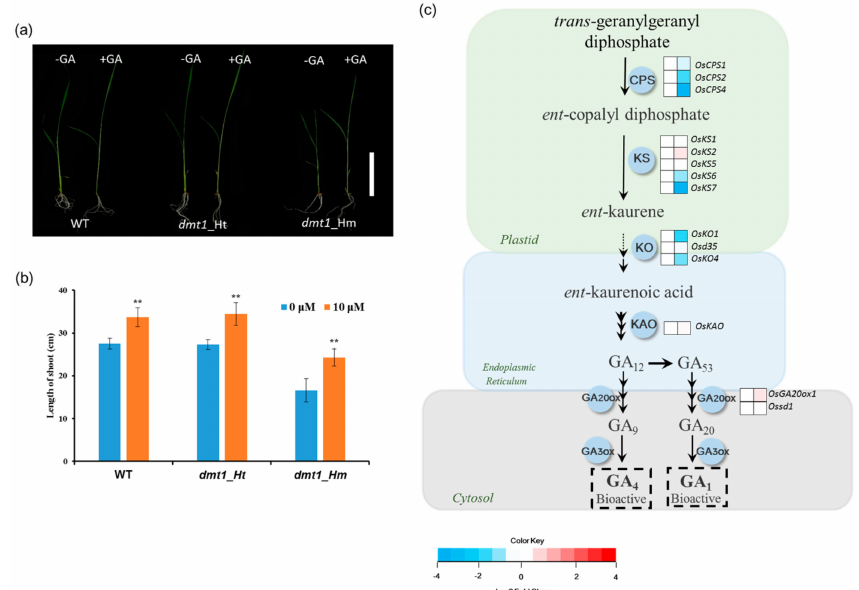
Figure 3. OsDMT1 involved in GA metabolism ( a ) GA response in the WT (left), heterozygous mutant (middle), and homozygous mutant (right). The 10-day-old WT, dmt1 homozygous, and heterozygous seedlings were sprayed with 0 µ M or 10 µ M gibberellin three times every 2 days, and the lengths of the shoots were measured on the 7 th day after the first treatment. Scale bar: 10 cm. ( b ) Quantitative measurements of the lengths of the shoot after GA treatment on the 7 th day in the WT, dmt1 heterozygous mutant and homozygous mutant. Values represented by means ± SE. ∗∗ p < 0.01, Student’s t -test; ( c ) Gene expression in the GA biosynthesis pathway between the dmt1 mutant and the WT. In the heatmap for each gene, two cells represent the WT and dmt1 mutant (left to right). Gene expression levels in the dmt1 mutant are indicated in the heatmaps by the log2 fold change relative to that of the WT. The dashed arrow represents several enzymatic reactions. CPS: ent-copalyl diphosphate synthase; KS: ent-kaurene synthase; KO: ent-kaurene oxidase; KAO: ent-kaurenoic acid oxidase; GA20ox: gibberellin 20-oxidase; GA3ox: gibberellin 3-oxidase; IPT: adenylate